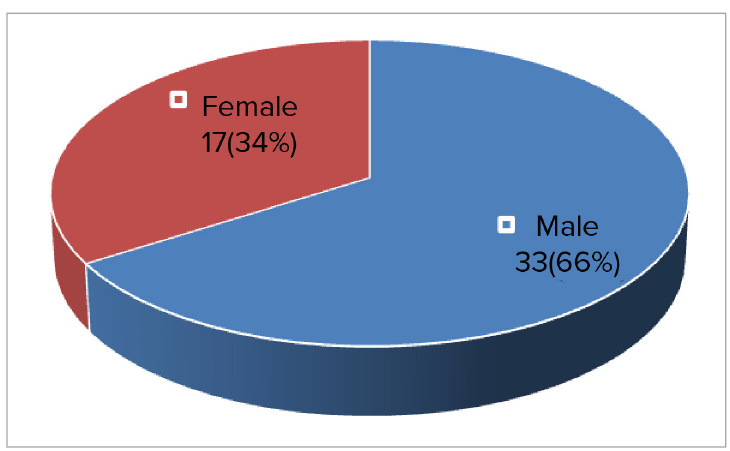
Figure 1: Distribution of Patients According to the